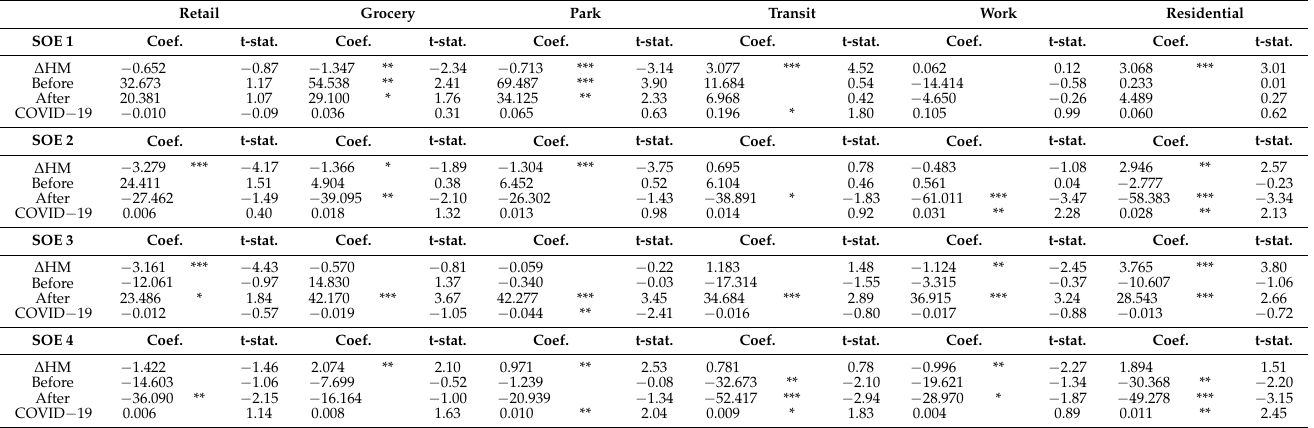
Table 8. ARDL short-term coefficient estimations.